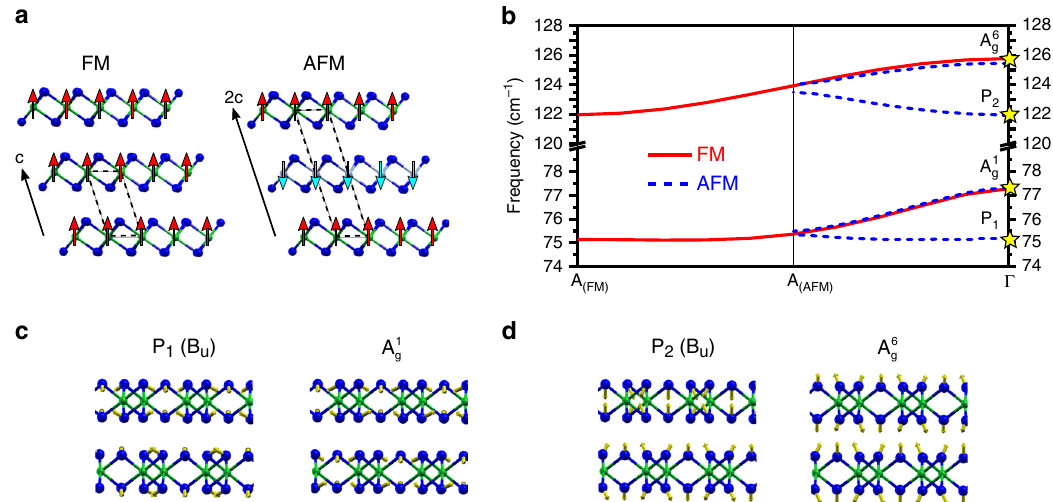
Fig. 5 Unit cells, phonon dispersions, and normal modes for FM and AFM stacking. a Comparing the unit cell for the FM and AFM stacked structures, where the AFM unit cell is doubled in the c direction. Chromium atoms are green, whereas iodine atoms are blue. b Calculated phonon dispersion showing the Raman-active modes in the FM (red, solid) and AFM (blue, dashed) stacking in bulk CrI 3 in the monoclinic crystal structure. In the AFM case, the doubling of the unit cell along the c direction in real space results in the A (FM) -point folding into Γ , such that the number of modes is doubled compared with the FM case. The Γ – A distance in the AFM case is half that of the FM case. Modes that correspond to P 1 , A 1 atomic vibrations are shown in c and d